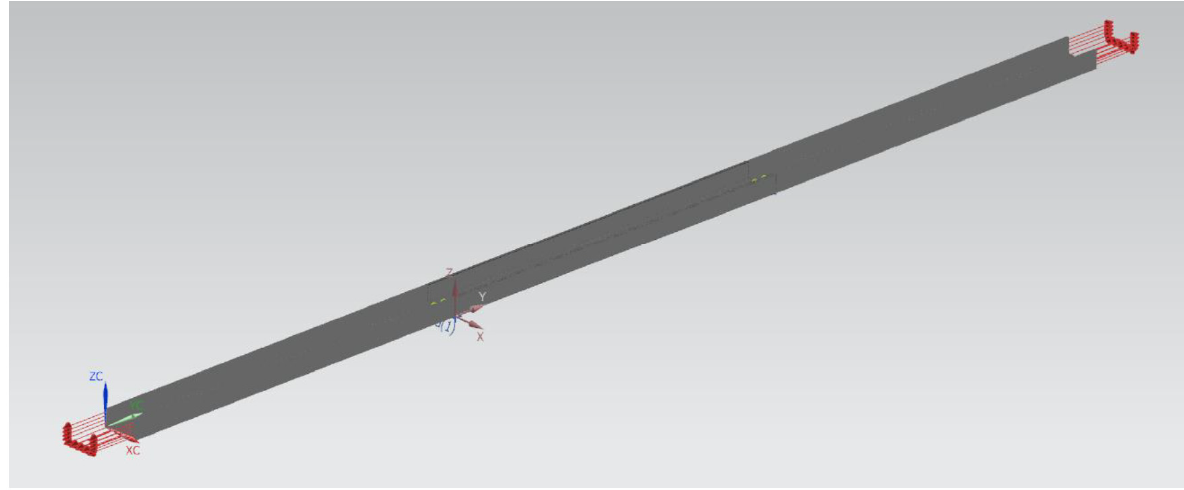
Figure 13. Load applied at the longeron.